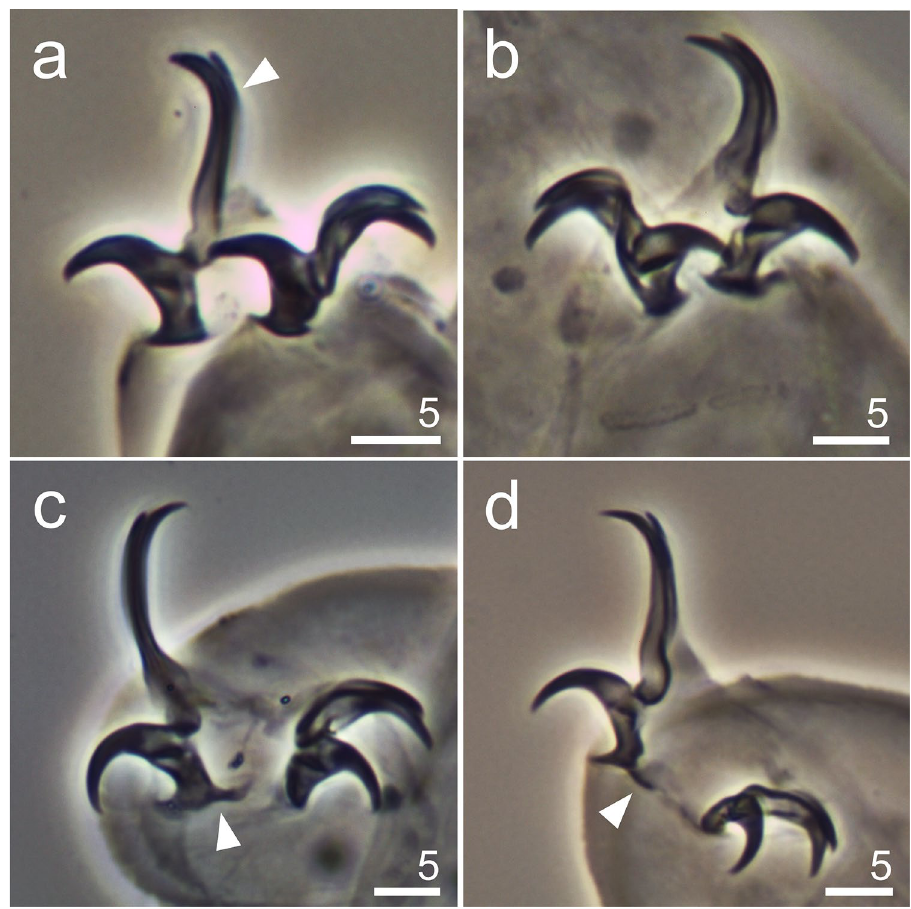
Figure 9. Hypsibius sp. from Mt. Gassan, claws (PCM): ( a ) claws I, arrowheads indicates accessory points, ( b ) claws II, ( c ) claws IV, arrowhead indicates widened posterior claw base, ( d ) claw IV, arrowhead indicates widened posterior claw base that form very faint connection between anterior and posterior